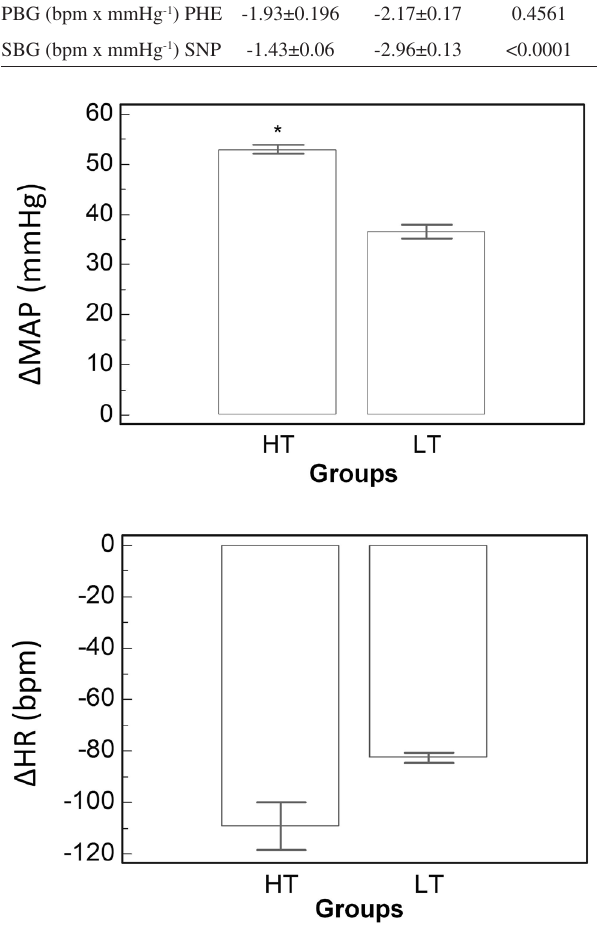
Figure 3 - Increase in mean arterial pressure (MAP, mmHg) and decrease in heart rate (HR, bpm) in response to phenylephrine (PE, 8 m g/kg i.v.) in HT (n=20) and LT (n=6) groups. * p<0.001: difference in LT. Means+SEM.